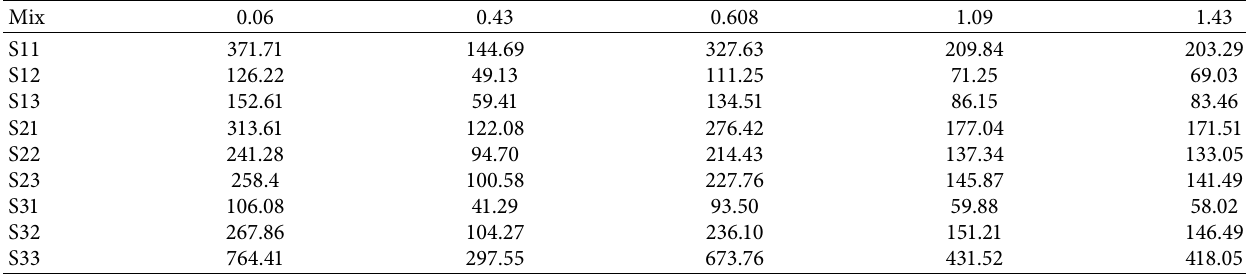
Table 10: Yield stress for various rev/sec.